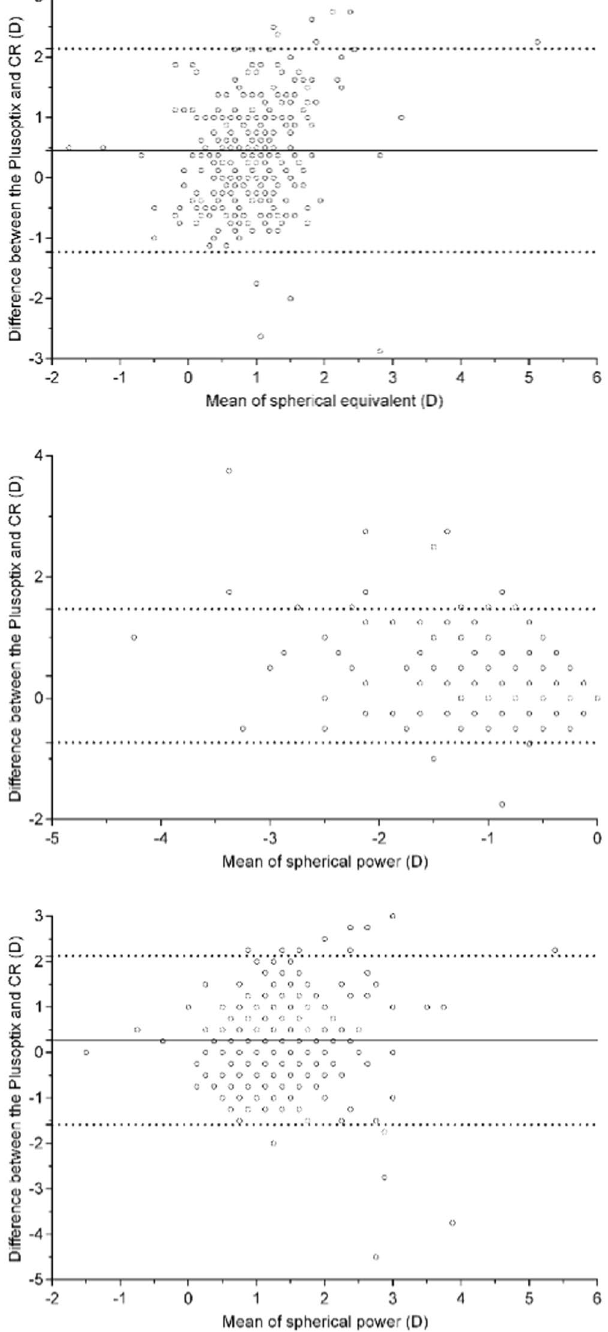
Figure 1. Bland-Altman plots showing the agreement between the plusoptiX A12C and cycloplegia retinoscopy. ( A ) The difference of sphere. ( B ) The difference of cylinder. ( C ) The difference of spherical